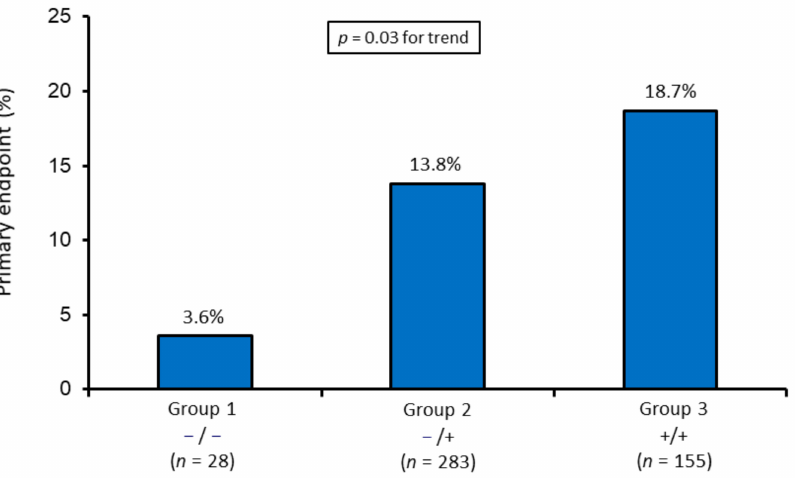
Figure 2. Rate of the primary endpoint (in-hospital mortality, acute pulmonary edema, and cardio- genic shock). Group 1 ( − / − ; no mitochondrial biomarker detected) vs. group 2 ( − /+; only one of the two biomarkers detected) vs. group 3 (+/+; both biomarkers detected)). p value for trend was obtained by Mantel–Haenszel